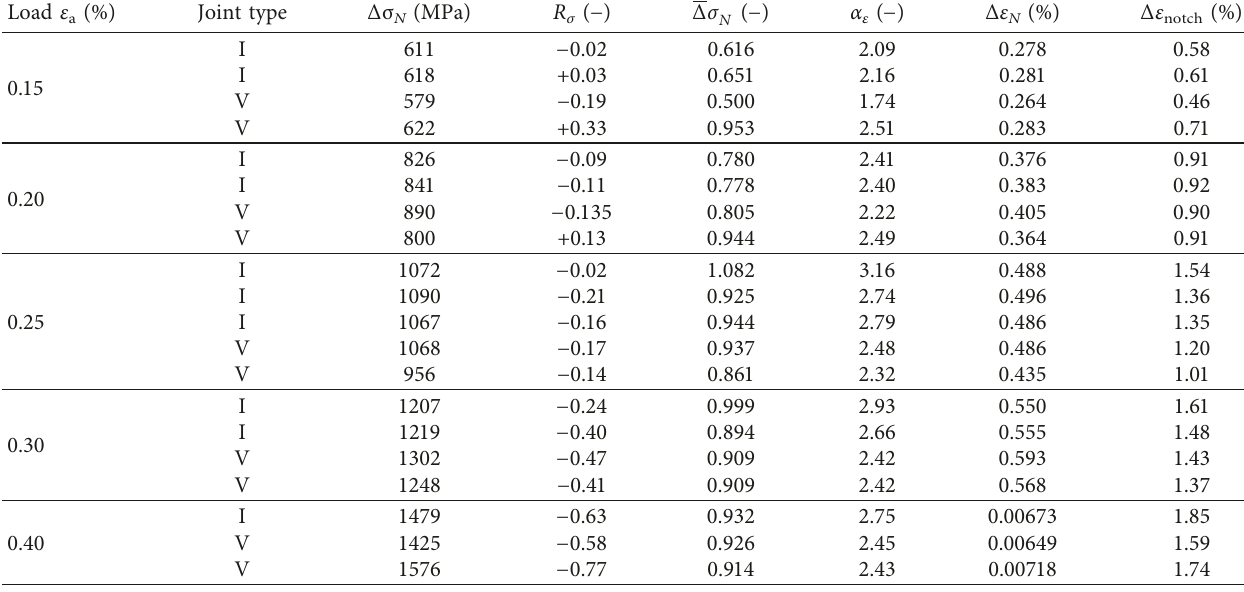
Table 5: Results of calculations of the strain range Δ ε